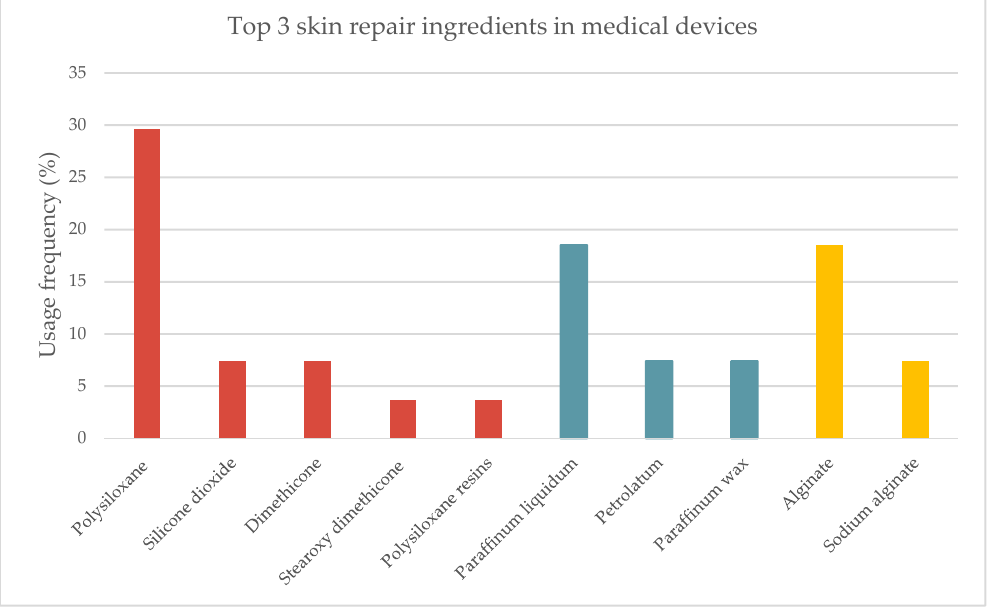
Figure 6. Usage frequency, in percentage, of the top 10 skin repair ingredients present in medical devices.